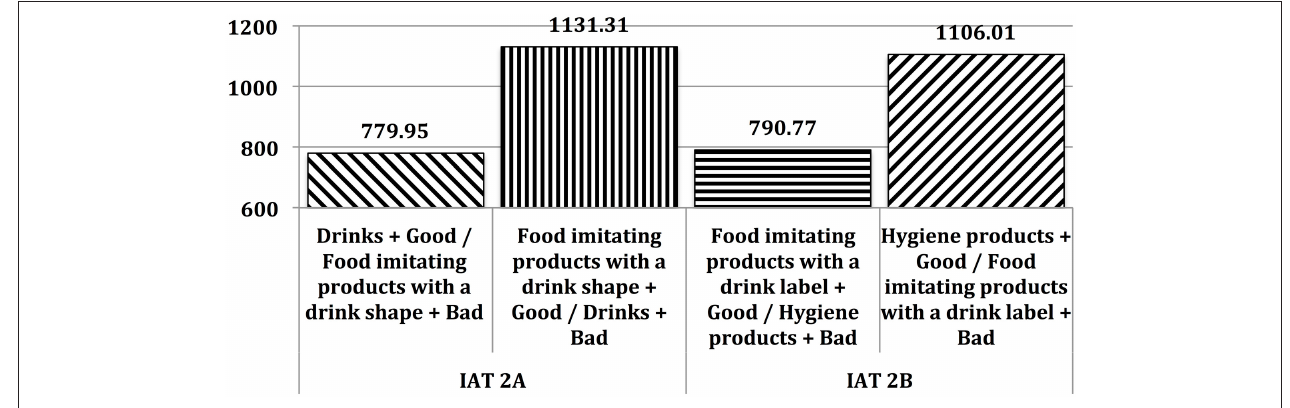
FIGURE 3 | Mean response latencies (in milliseconds) in Study #2.